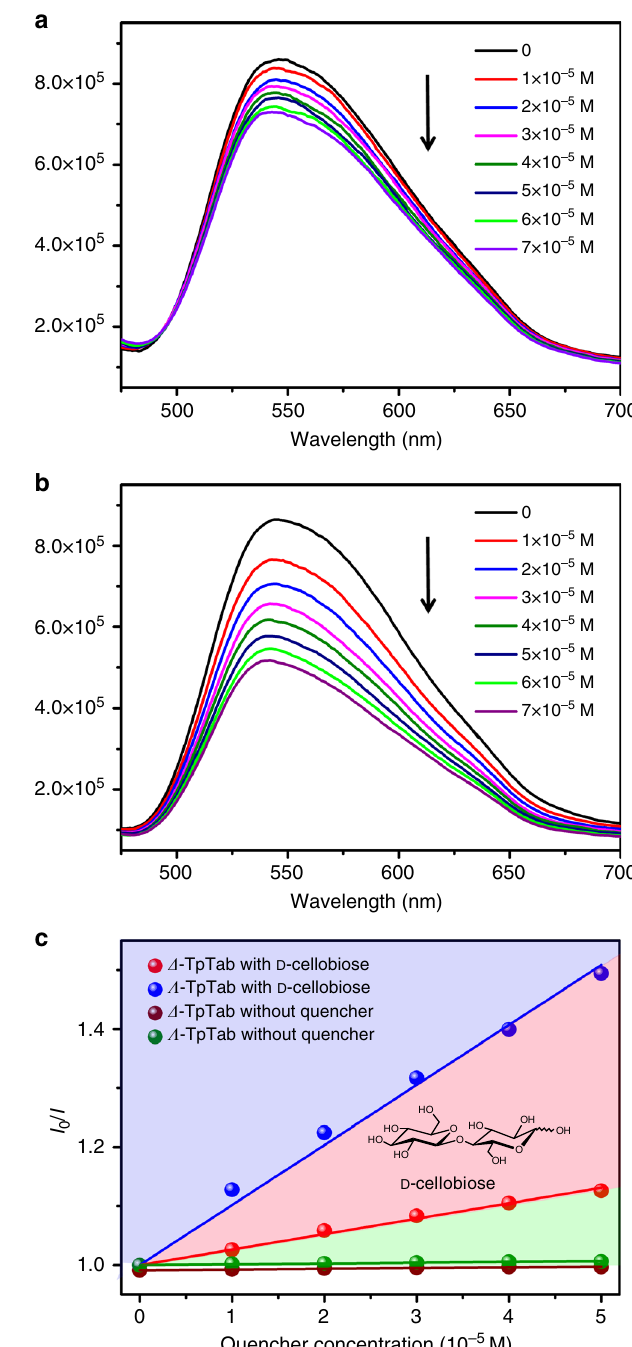
Fig. 7 The fl uorescence quench spectra of CCOFs TpTab. a , b Fluorescence emission spectra of ( Λ )/( Δ )-TpTab with increasing concentration of the D - cellobiose quencher in solution: 0, 1, 2, 3, 4, 5, 6, and 7 × 10 − 5 M D -